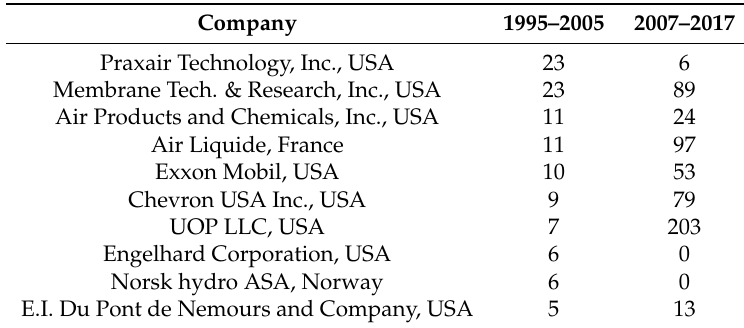
Table 3. Evolution of published patents of the 10 most active companies between 1995 and 2005 according to Ebner and Ritter